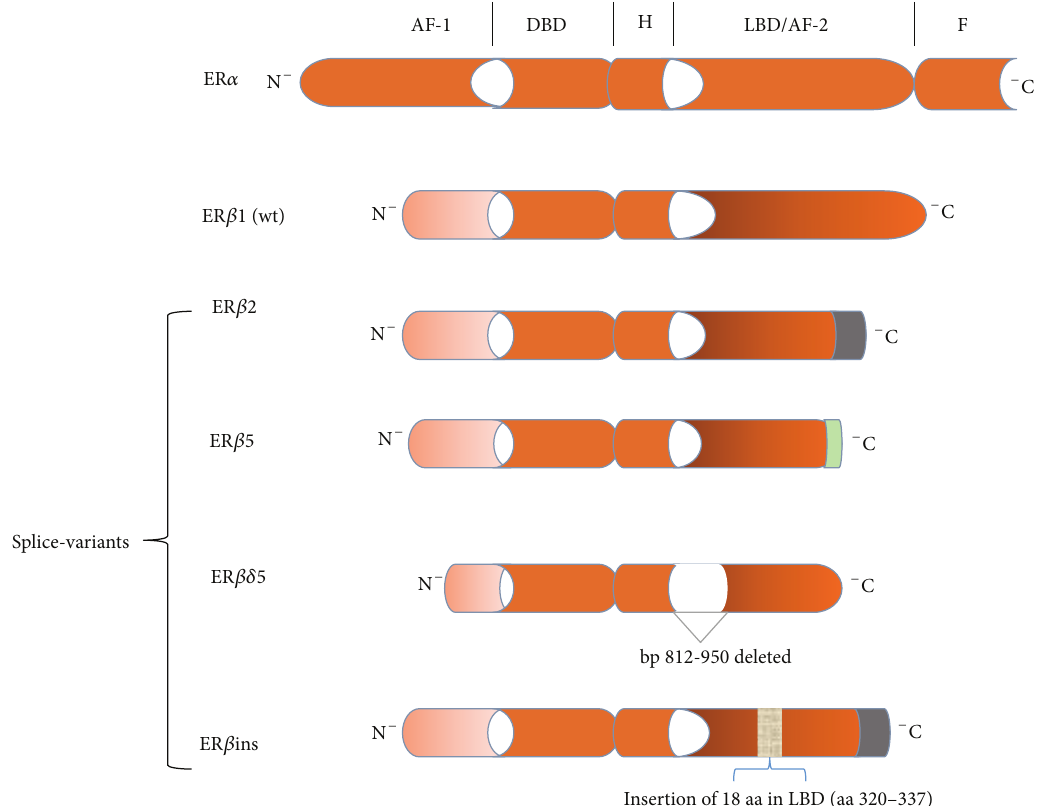
Figure 4: ER 𝛽 splice variants. The AF1 and AF2 domains exhibit the least homology between ER 𝛽 1 and ER 𝛼 . ER 𝛽 2 is nearly identical to ER 𝛽 1 except that the last 61 amino acids (aa) are replaced by 26 novel aa (indicated by the green portion of the receptor). As such, the 𝛽 2 splice variant is comprised of 495 aa. Similarly, the last 65 aa of ER 𝛽 5 has been replaced by 7 other aa resulting in a 472 aa protein. Of note, truncation of the LBD/AF1 domains of 𝛽 2 and 𝛽 5 results in loss of ligand-binding activity, while conservation of their DBD maintains the likelihood of ERE binding. Estrogen binding to the delta5 splice variant is compromised by deletion of nucleotides 812–950 (139 base pairs (bp)) in the LBD. The result of the 18 aa insertion into what is essentially ER 𝛽 2 markedly diminishes ligand